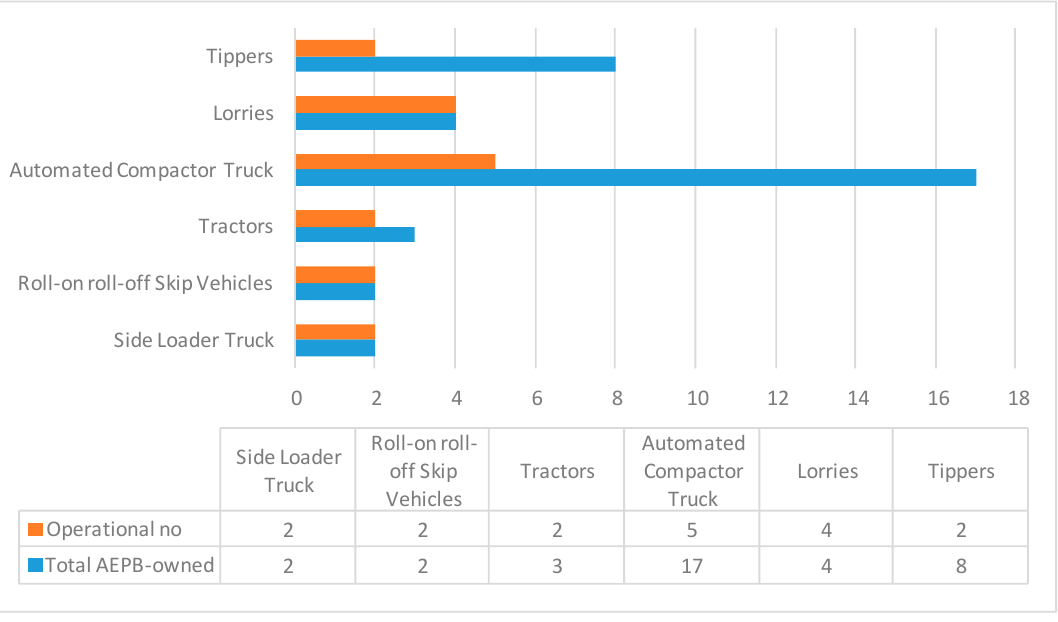
Figure 1. Distribution of waste collection, transportation and disposal vehicles in Abuja. Source :